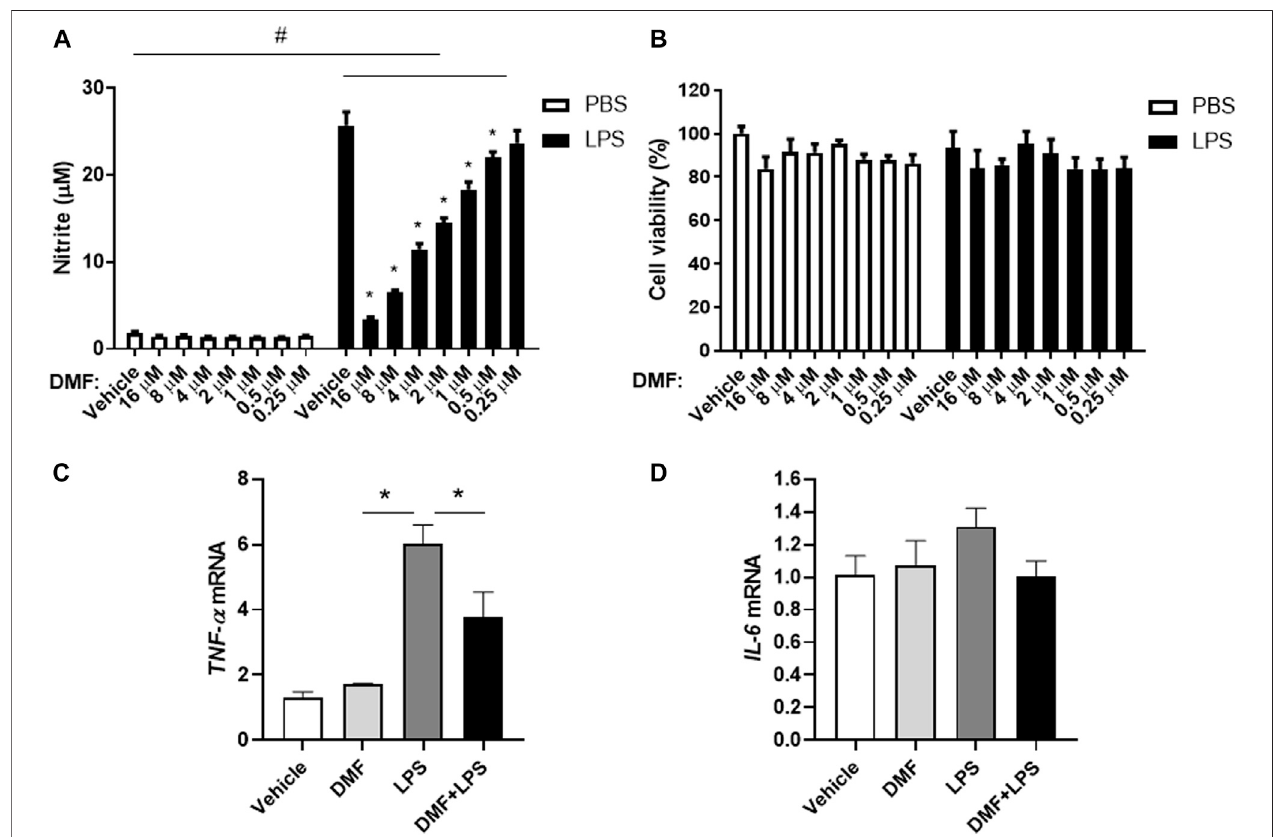
FIGURE2| DMFreducesin fl ammationinmicroglia.HAPIcellswereseededat4 × 10 4 cells/wellina96-wellplateandincubatedovernight.Cellswerethentreated with indicated concentration ofDMF with or without LPS. After 24 h, nitric oxide (NO) production was measured by the Griess assay (A) , and cell viability was measured bytheMTTassay (B) . (C,D) HAPIcellswereseededat1 × 10 6 cells/wellina6-wellplateandincubatedovernight.Cellswerethentreatedwith4 μ MDMFwithorwithout LPS (100 ng/ml). After 6 h, the mRNA expression levels of tumor necrosis factor-alpha ( TNF- α ) (C) and interleukin- 6 ( IL-6 ) (D) was determined by real-time quantitative polymerase chain reaction (RT-qPCR). Fold changes were calculated as the ratio of expression level in the LPS-only treated group. n (cid:2) 3 independent experiments/group. Data are presented as means ± SEM. * P < 0.05 compared with LPS-only treated group, # P < 0.05 compared with vehicle-only treated group from two-way ANOVA with multiple comparison